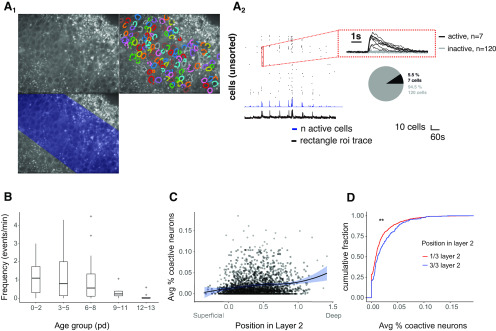
Comparison of spontaneous network activity in layer 2a and layer 2b neurons. A1, Example of a baseline GCaMP-fluorescence image from an Ai95-NexCre mice. The field of view covers layer 2 in aPCx. Top right, Detected cells in layer 2. Bottom, Rectangular ROI defined by the upper and lower boundaries of layer 2 for detecting global activity. A2, Corresponding traces from the global events measured from the rectangular ROI (fluorescence: black trace, bottom) and the active cells (raster plot, blue trace for number of active cells, red inset for fluorescent traces from individual neurons in raster plot). The proportion of active versus inactive cells is indicated by pie chart for one event. B, Frequency of spontaneous events per minute measured at five different age groups (expressed as postnatal days, pd; n = 70/59/36 fields of view/slices/mice). C, For each active neuron, the average percentage of coactive neurons (based on the total number of neurons in the field of view) was plotted against the position of the active neuron in layer 2 in the aPCx (data are fitted with a local polynomial regression and pooled from the first postnatal week). D, Layer 2 was divided in three parts. Cumulative distribution of the average percentage of coactive neurons from C was plotted for the superficial third (red, 1/3 layer 2, corresponds to layer 2a neurons) and the deep third (blue, 3/3 layer 2, corresponds to layer 2b neurons); **p < 0.01. See Extended Data Table 1-2 for statistical details.Figure Contributions: Stephen Lenzi performed the experiments and analyzed the data.